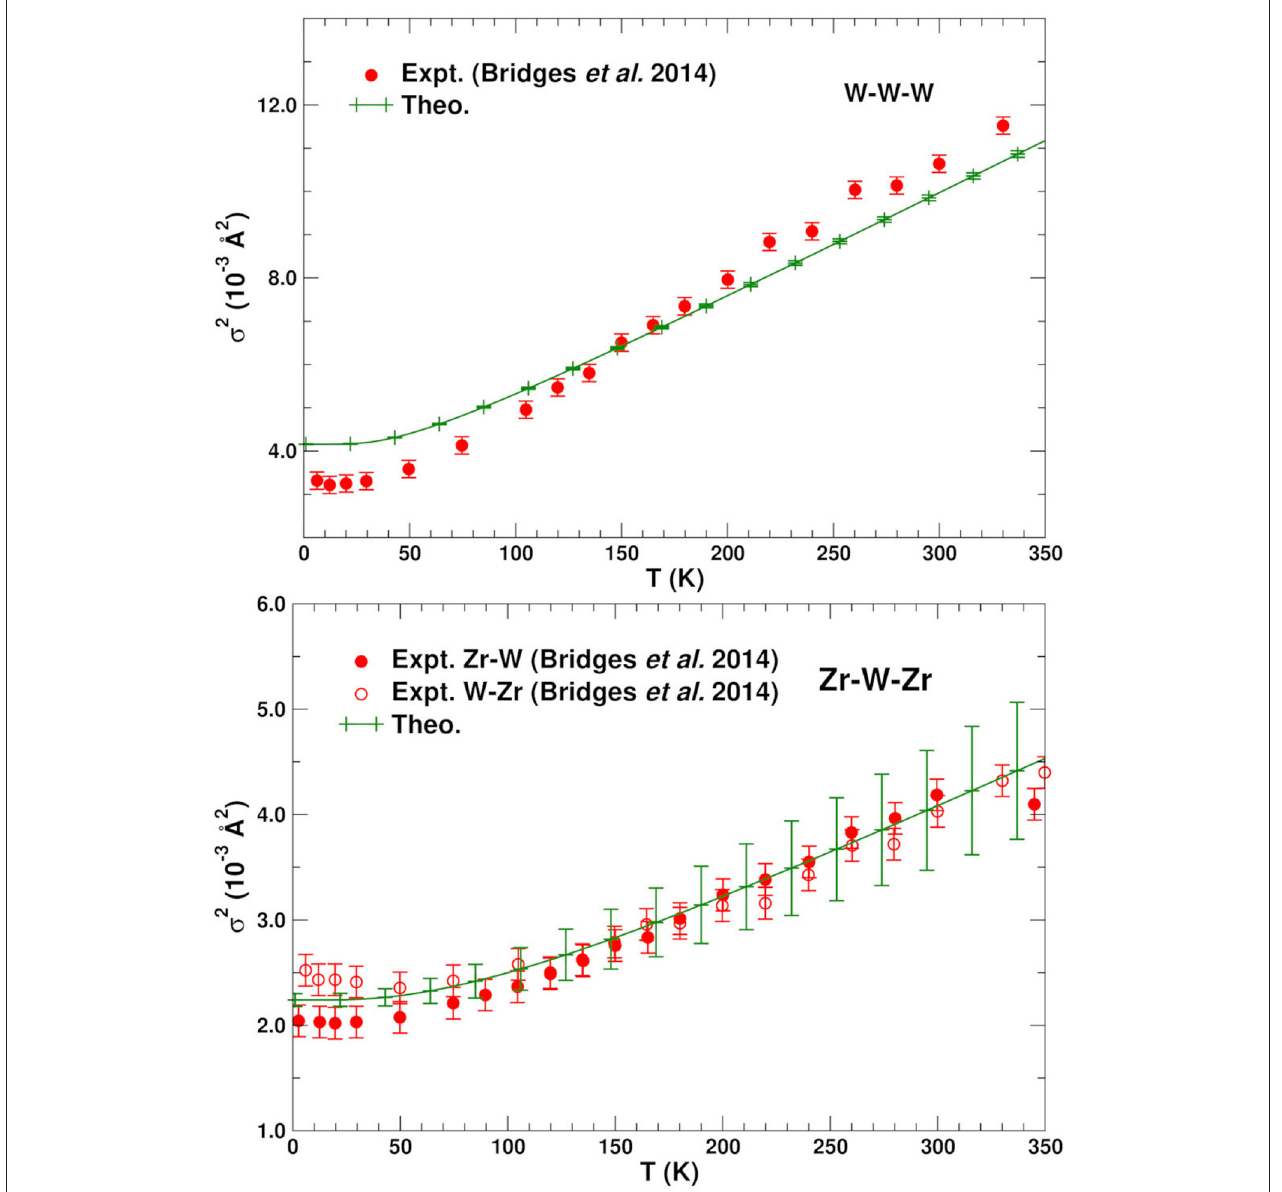
FIGURE 3 | Comparison of the experimental (Bridges et al., 2014) and theoretical mean single scattering MSRD σ 2 p for the W–W–W and Zr–W–Zr bonds in ZrW 2 O 8 . The theoretical values have been shifted vertically to account for experimental static